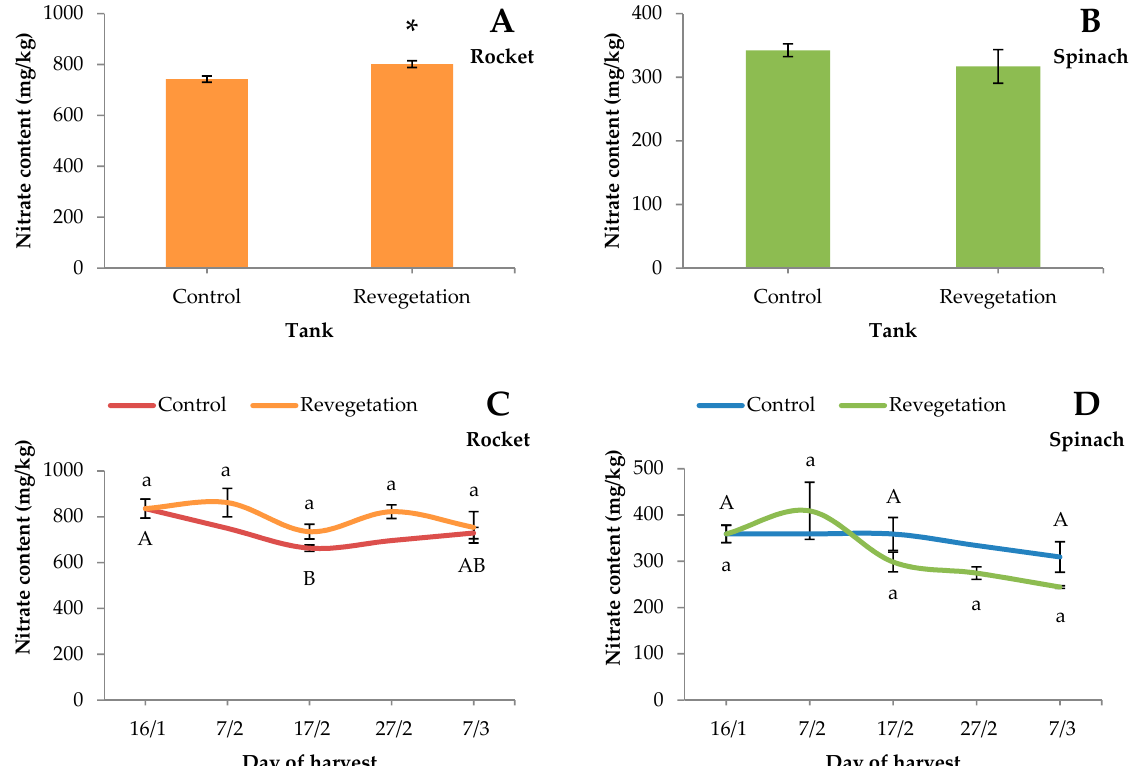
Figure 2. Nitrate content derived from all harvests ( A , B ) or from individual harvests ( C , D ) of rocket ( A , C ) and spinach ( B , D ) baby leaves cultivated in control or revegetation tanks. Means of control and revegetation tanks were computed from three and five harvests, respectively. In ( A , B ), bars ( ± SE) followed by an asterisk are significantly greater ( p ≤ 0.05). In ( C , D ), lines ( ± SE) followed by different letters (upper-case or lower-case) are significantly different ( p ≤ 0.05).